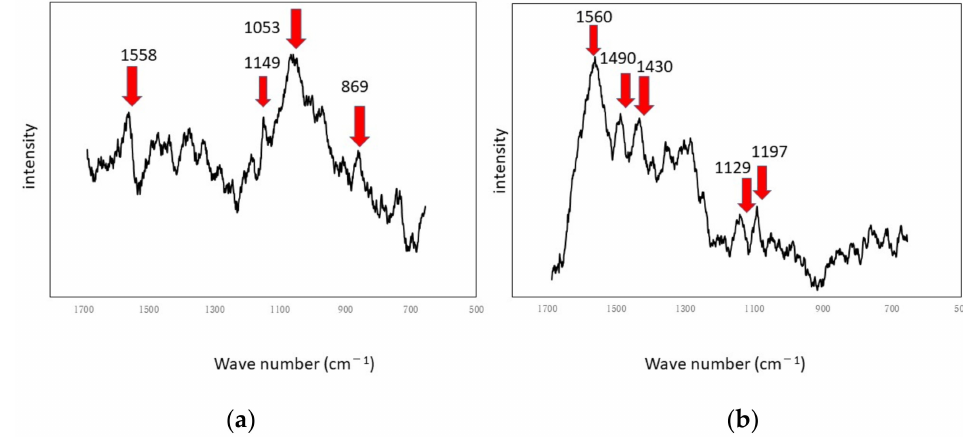
Figure 6. Raman shifts by the SDRBR: ( a ) titanium specimen and ( b ) aluminum specimen. The shaded areas one observes by using optical microscopes often correspond